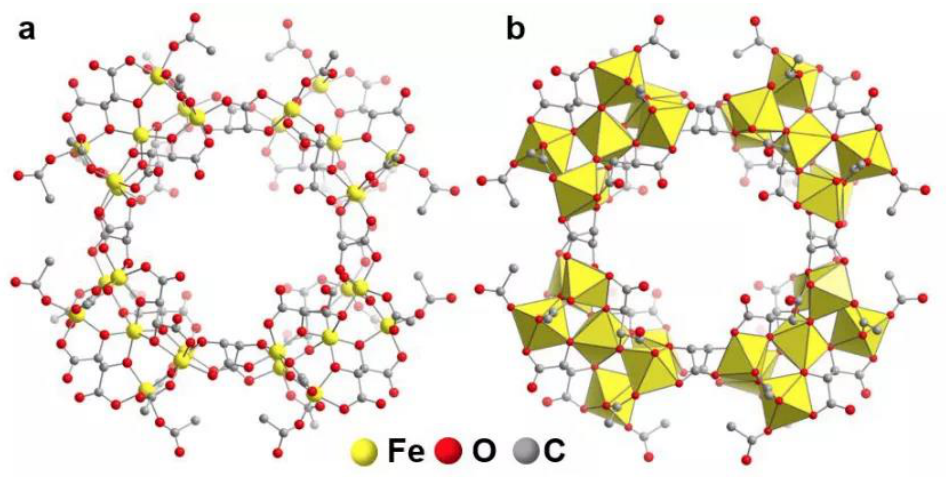
Figure 24. ( a ) Ball-and-stick representation of Fe 28 . ( b ) Polyhedral representation of Fe 28 , showing the wheel-like structure assembled from tartrate-linked Fe 7 building units. (Reprinted with permission from [334]. Copyright 2022, John Wiley and Sons).